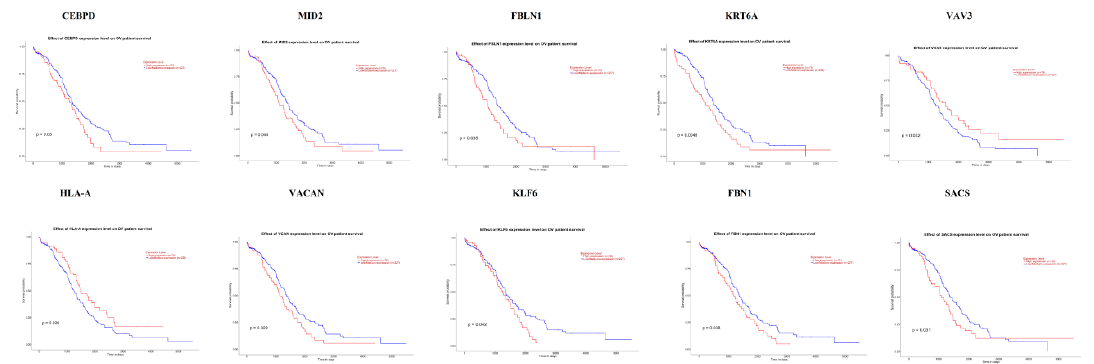
Figure 17. Validation of the expression of hub genes in the TCGA database. High expression of hub genes in stages2 and 4.